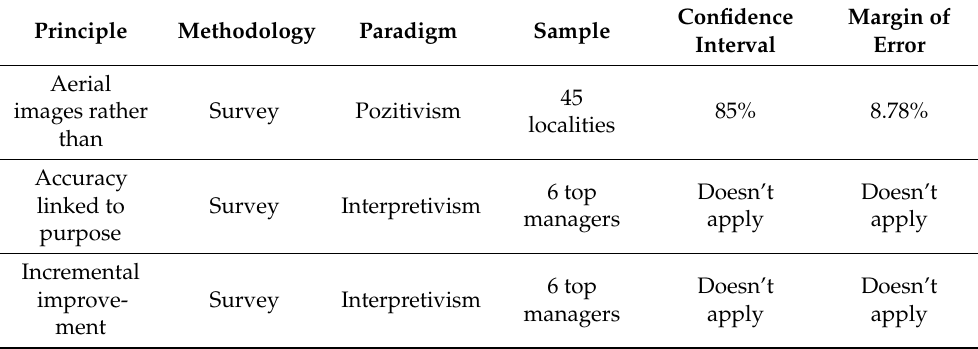
Table 2. Samples used for qualitative study for principles of accuracy linked to purpose rather than technical standards and incremental